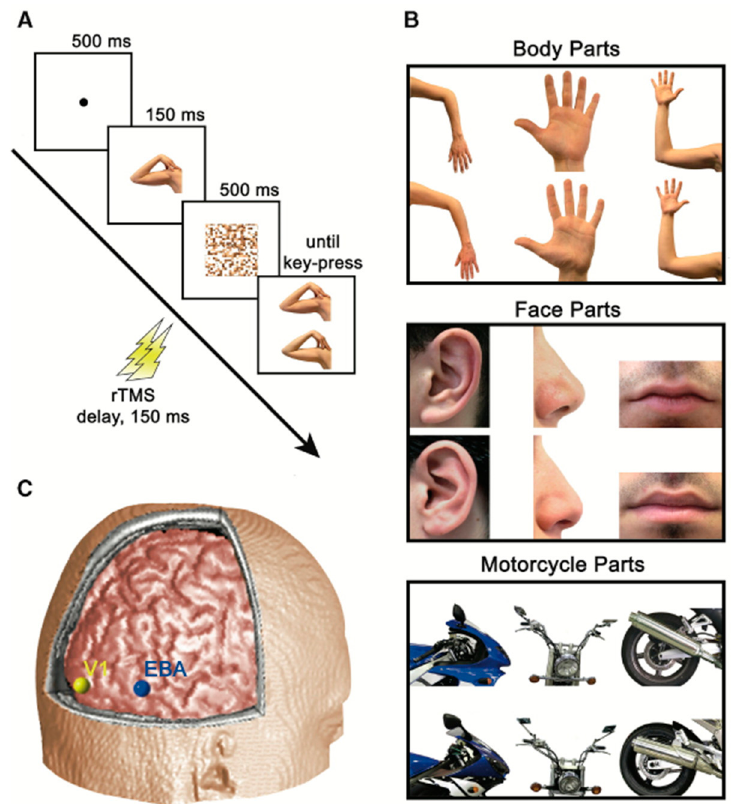
Figure 8. The experiment conducted by Urgesi et al. wherein panel ( A ) depicts rTMS being delivered after 150 ms of stimulus presentation, panel ( B ) shows stimulus categories, and panel ( C ) displays the positions of stimulation sites which include EBA (shown in blue), and primary visual cortexV1 (shown in yellow). Panels ( A – C ) adapted with permission from Urgesi et al. (2004). The fusiform body area (FBA) is another region that is implicated in body perception;